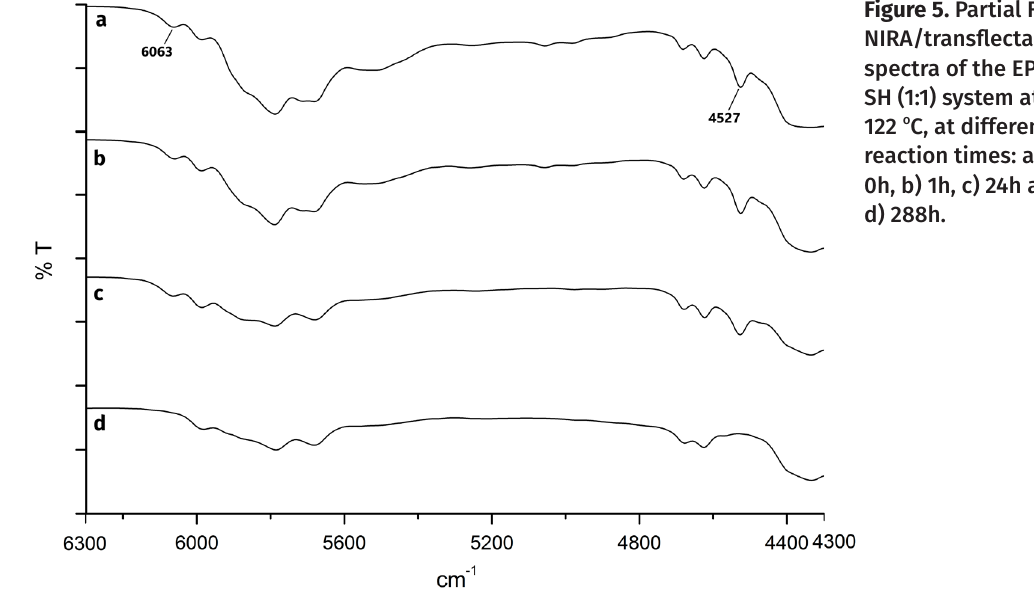
Figure 5. Partial FT- NIRA/transflectance spectra of the